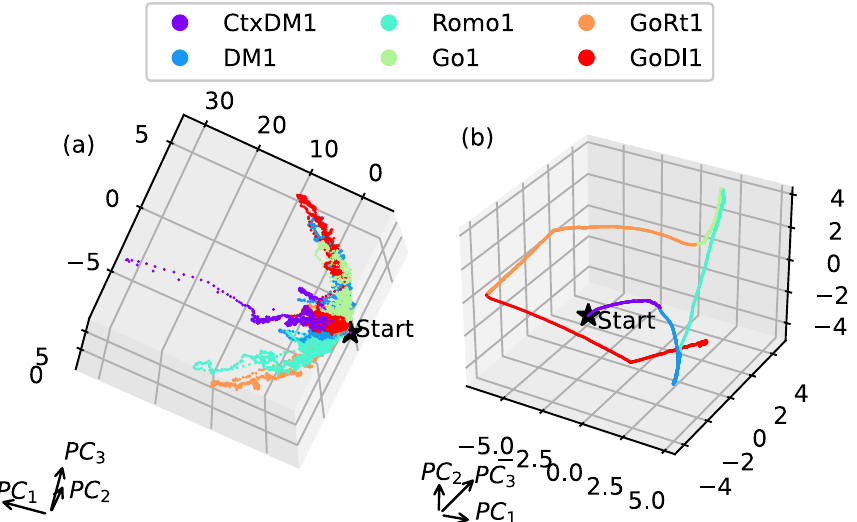
Figure 10. Projections of the neural activity trajectories onto the subspace of the first three principal components for variables v j ( a ) and a j ( b ) for the network with 256 neurons and the regularized loss function when performing a sequence of different tasks. The network state at the end of each trial is the initial condition for the next task.